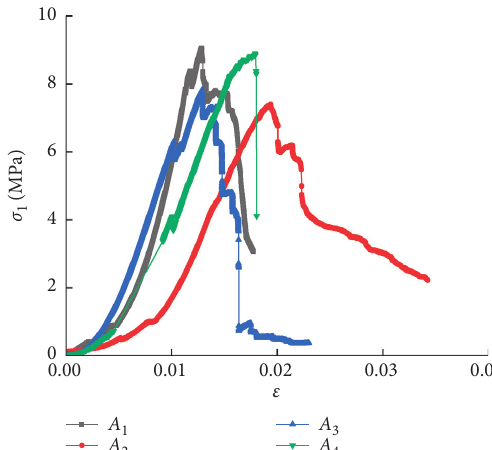
Figure 5: Stress-strain curves of coal samples from coal mine